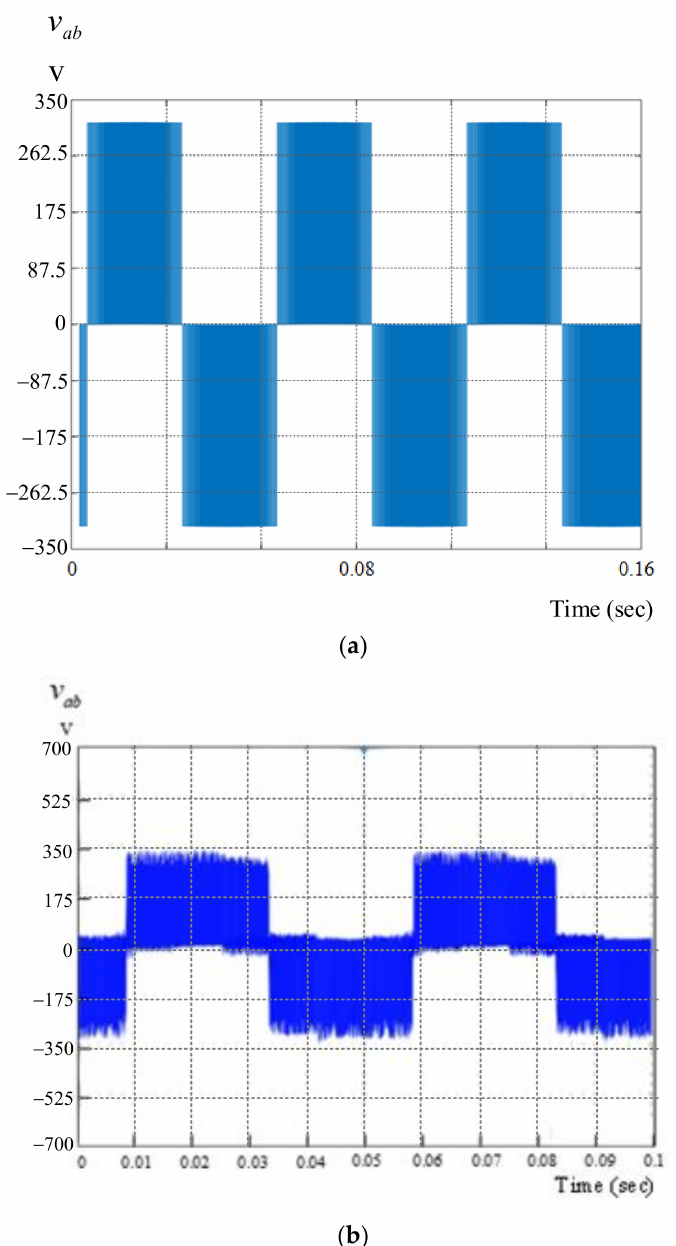
Figure 6. Line–line voltage of motor. ( a ) Simulated; ( b )